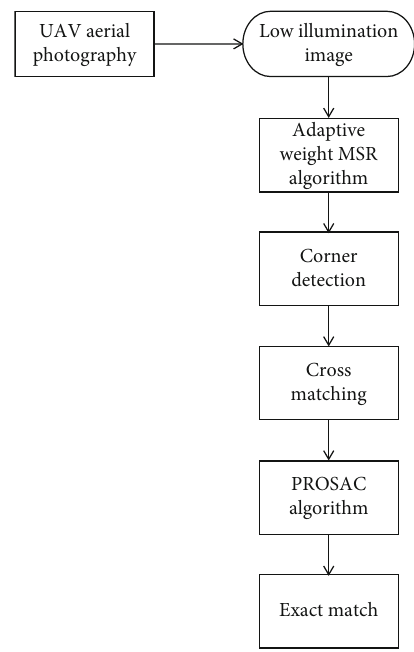
Figure 1: Algorithm fl ow chart of this